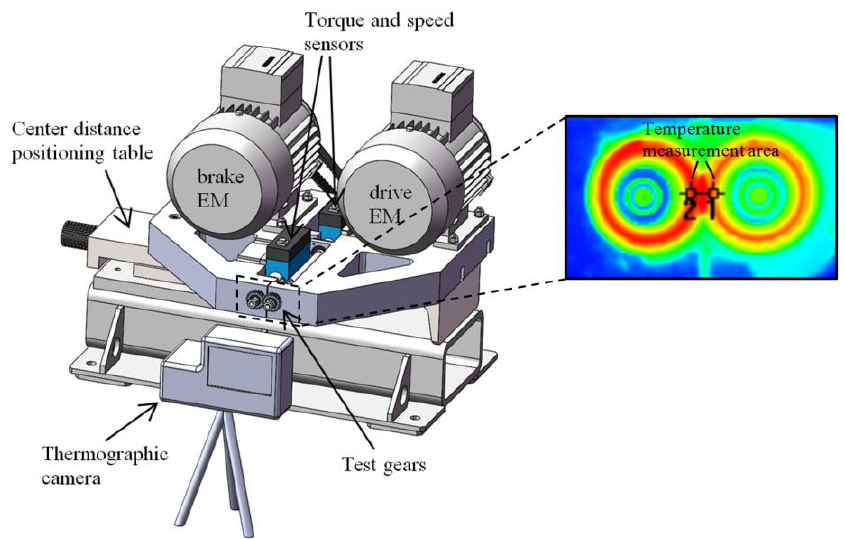
Figure 8. Durability gear testing on test rig with control of speed, torque, and temperature.